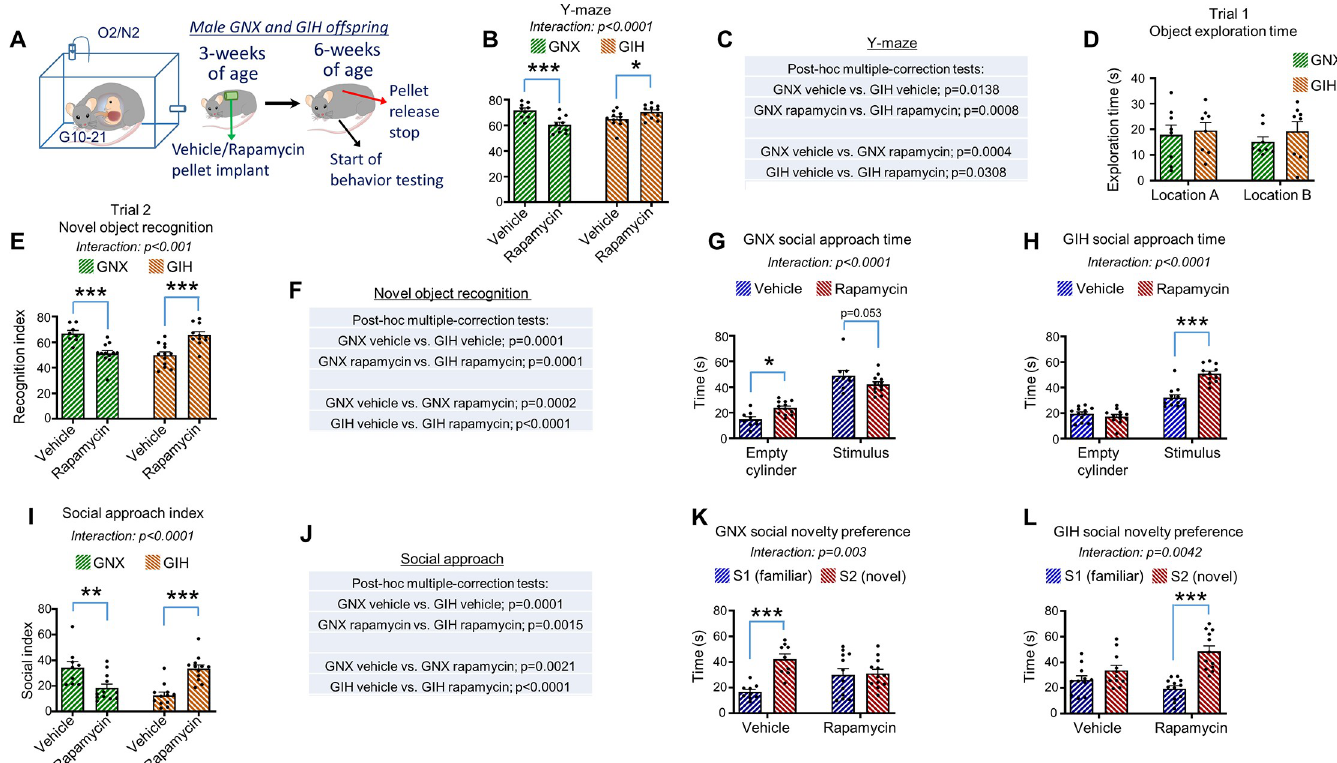
Fig 9. Rapamycin rescue of GIH male behavioral impairments. (A) Experimental approach. Three-week-old GNX and GIH male offspring were implanted with 21-day rapamycin or vehicle slow-release pellets. Following the cessation of the rapamycin or vehicle release (6 weeks of age), behavioral assessment commenced. (B